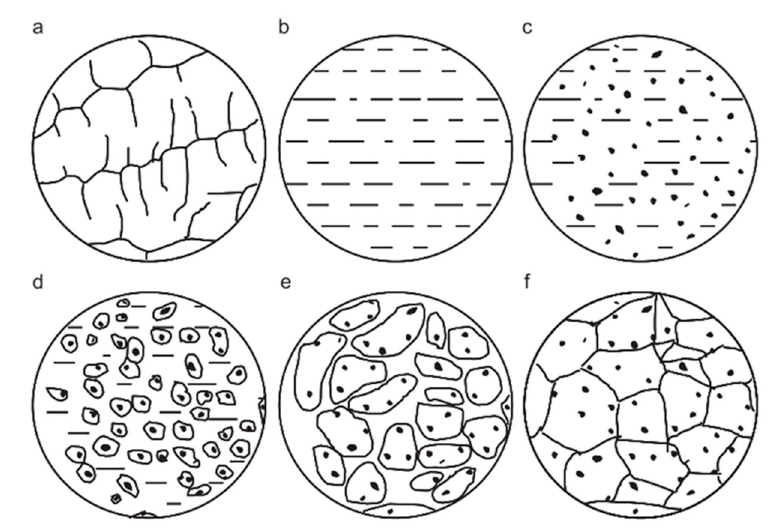
Figure 20. Schematic diagram of solidification: ( a ) original microstructure; ( b ) melts; ( c ) in situ reac- tion; ( d ) nucleation; ( e ) growth and aggregation; ( f ) ultimate microstructure [12]. Reprinted/adapted with permission from Ref. [12]. Copyright year 2013, Elsevier.